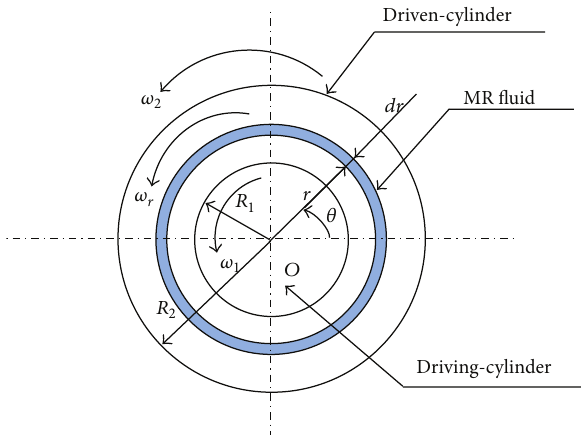
Figure 5: Shear transmission model of cylinder type MR